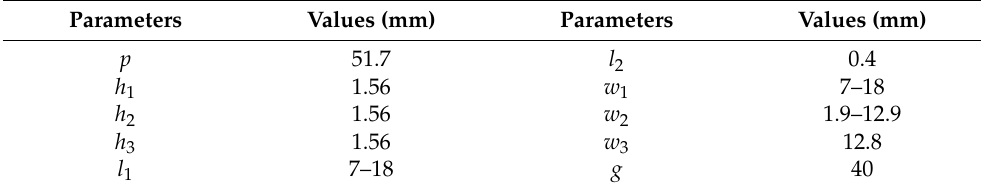
Figure 3. Geometry of the unit cell and the patch antenna: ( a ) isometric view of the unit cell; ( b ) top and bottom layers of the unit cell; ( c ) middle layer of the unit cell; and ( d ) patch antenna source. Table 1. Design parameters for the unit cell and the patch antenna